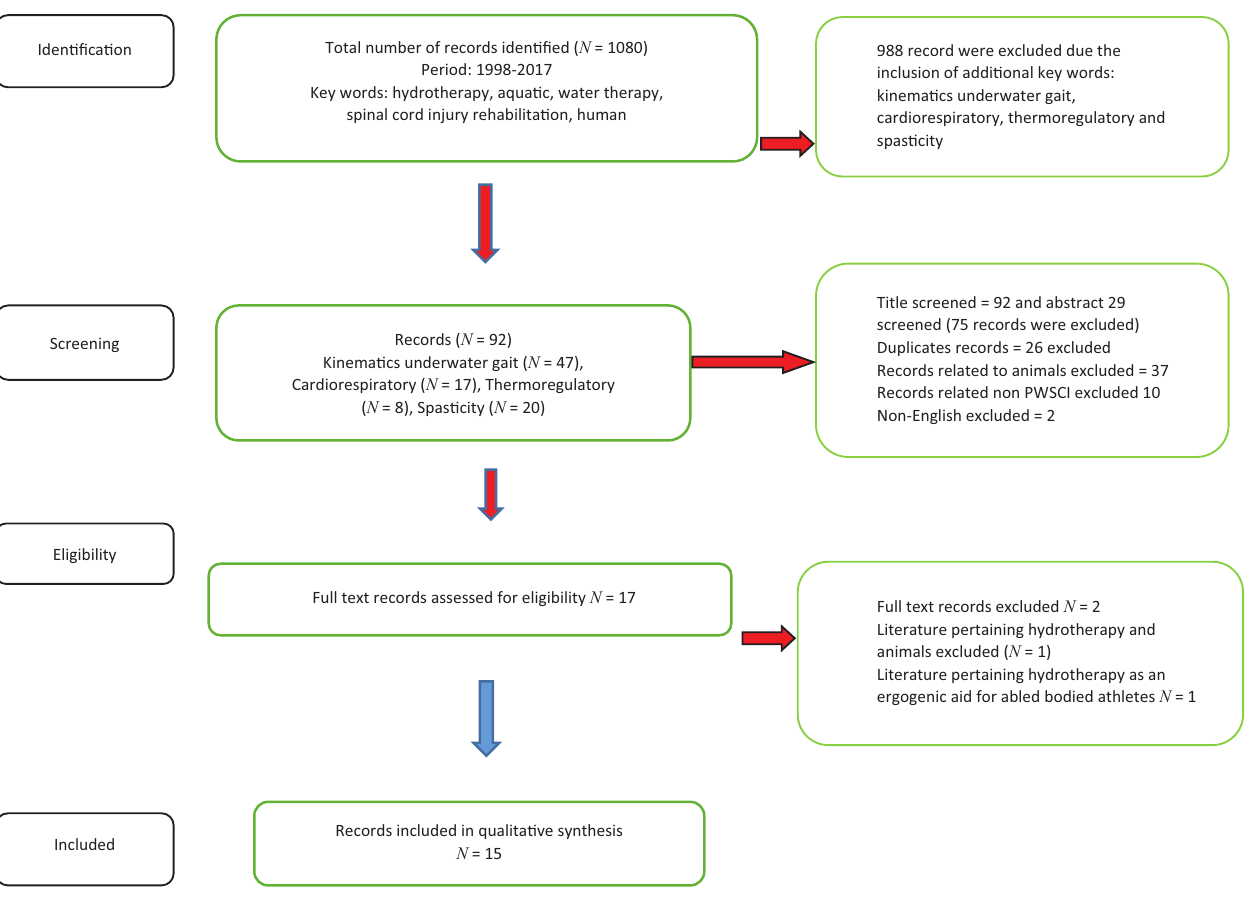
FIGURE 1: Flow chart of the review